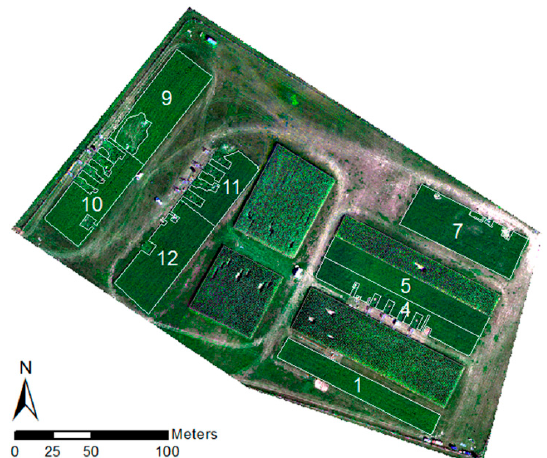
Figure 13. RGB composite image of the CarboZALF experimental area from calibrated Mini-MCA 12 bands b 658 , b 551 and b 471 .